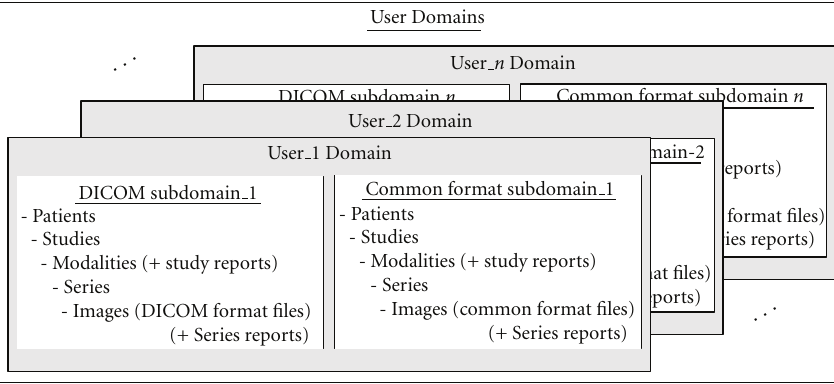
Figure 2: The structure of the User